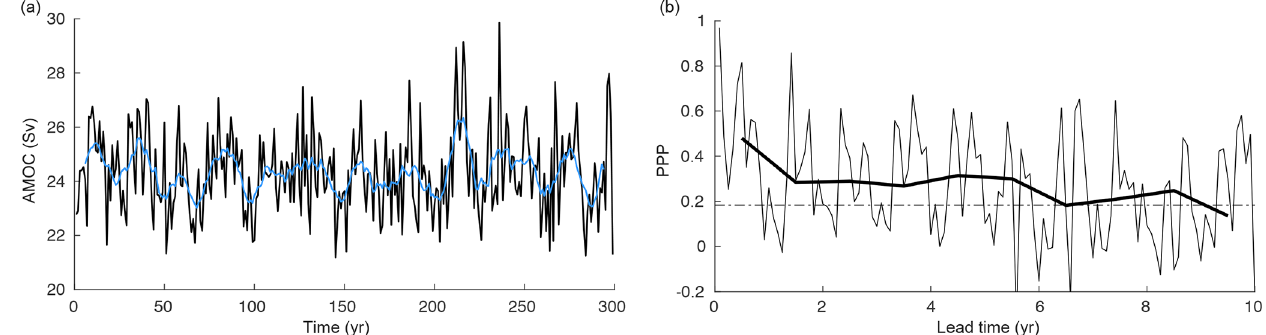
Figure C1. (a) Simulated annual mean AMOC maximum of the 300-year-long preindustrial control simulation. The blue line indicates the 10-year running mean. (b) Monthly mean (thin line) and annual mean (thick line) prognostic potential predictability for the AMOC maximum. The horizontal black dashed line represents the predictability